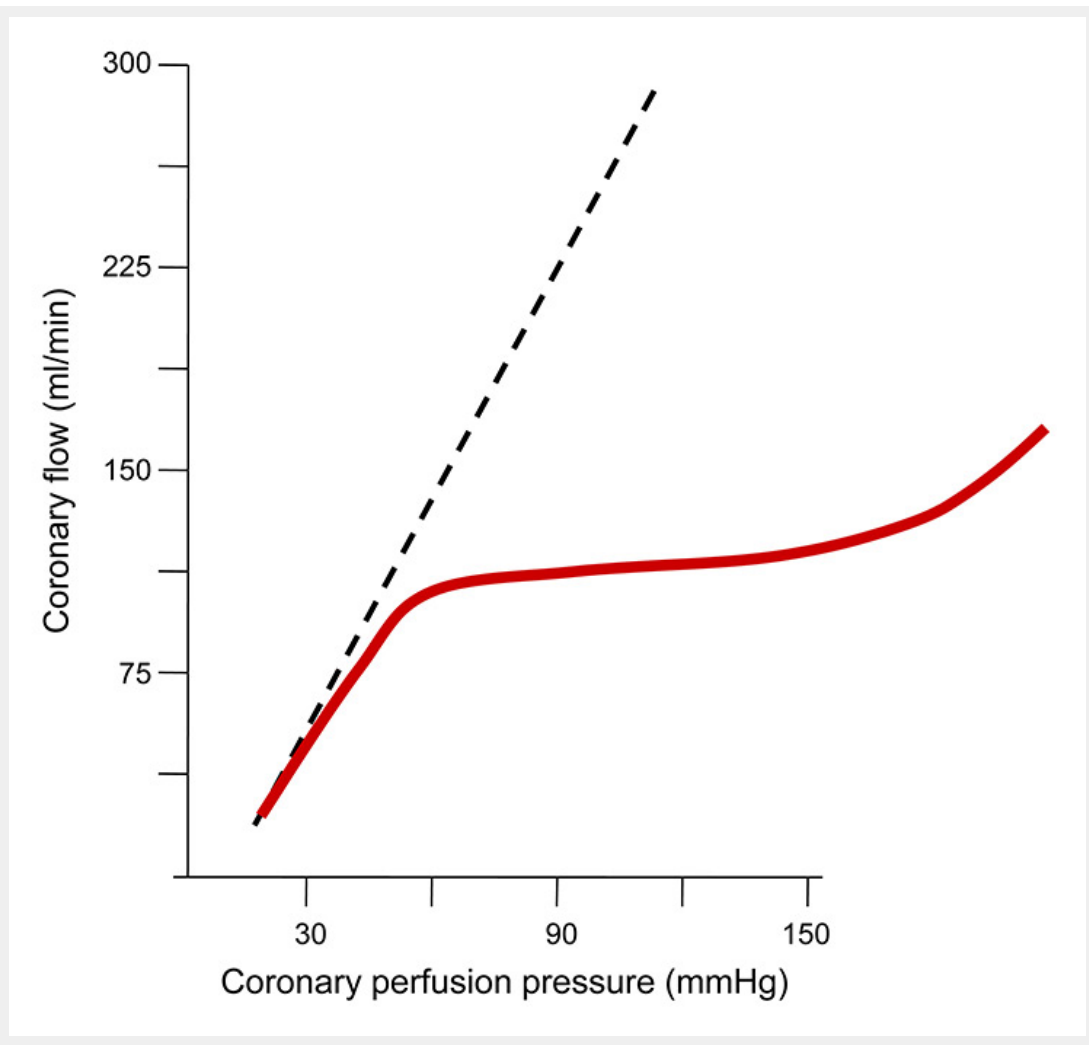
Figure 2 Schematic illustration of autoregulation of coronary blood flow, which is constant at around 1 ml/min over a wide range of perfusion pressures (red line). During the state of maximum microcirculatory vasodilation (broken line), i.e., minimum resistance, coronary flow varies directly with varying perfusion